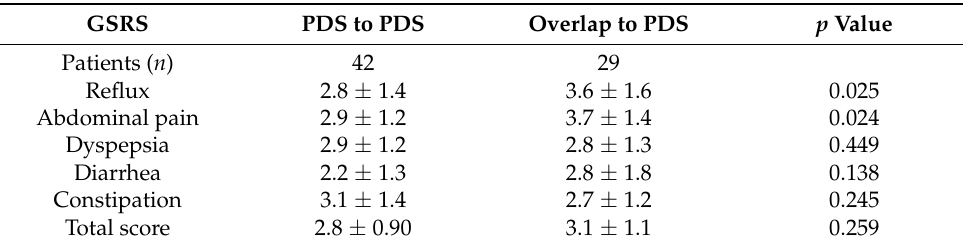
Table 4. GSRS (PDS to PDS vs. overlap to